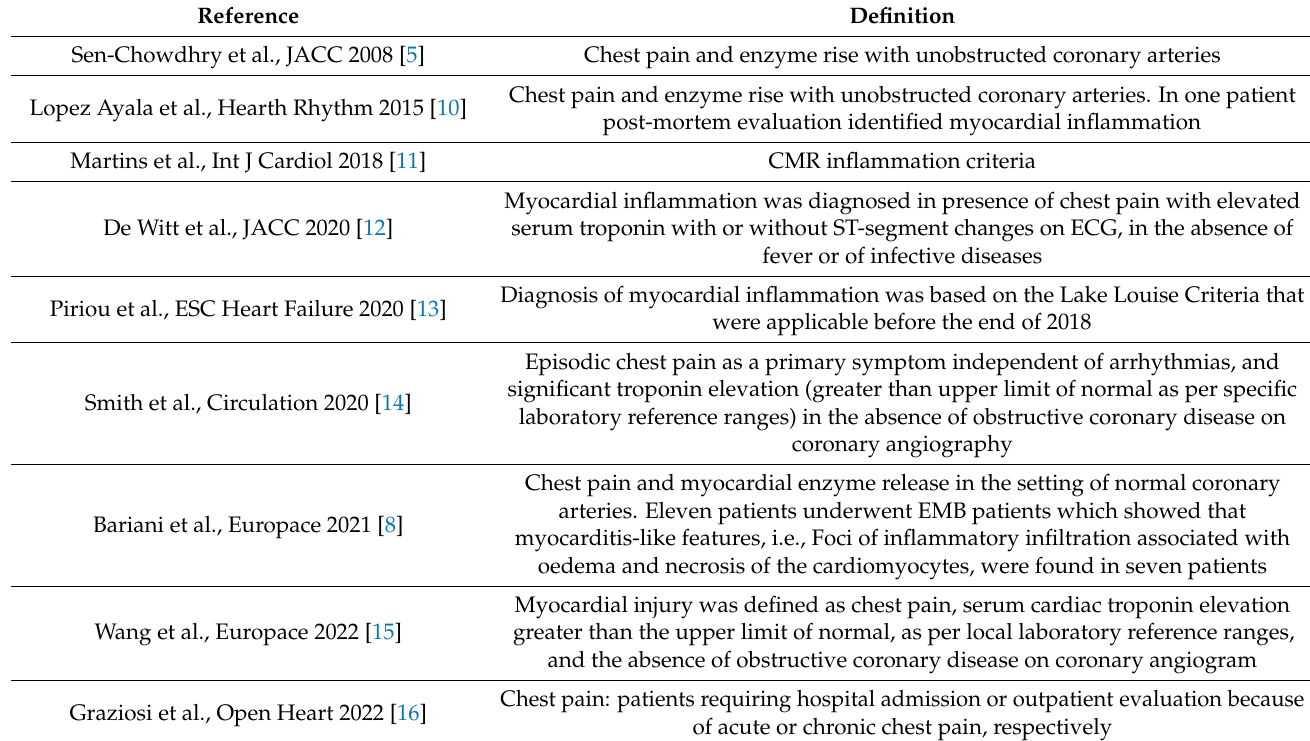
Table 2. Definition of “hot-phase” provided in the nine selected